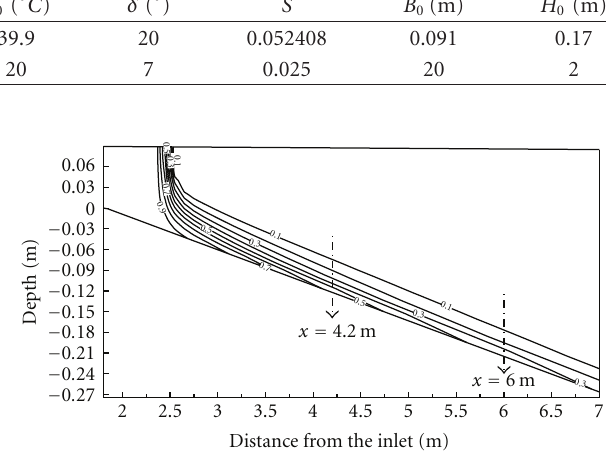
Table 1: The parameter values for the numerical simulations of the continuous density currents in an inclined diverging channel. Presented by